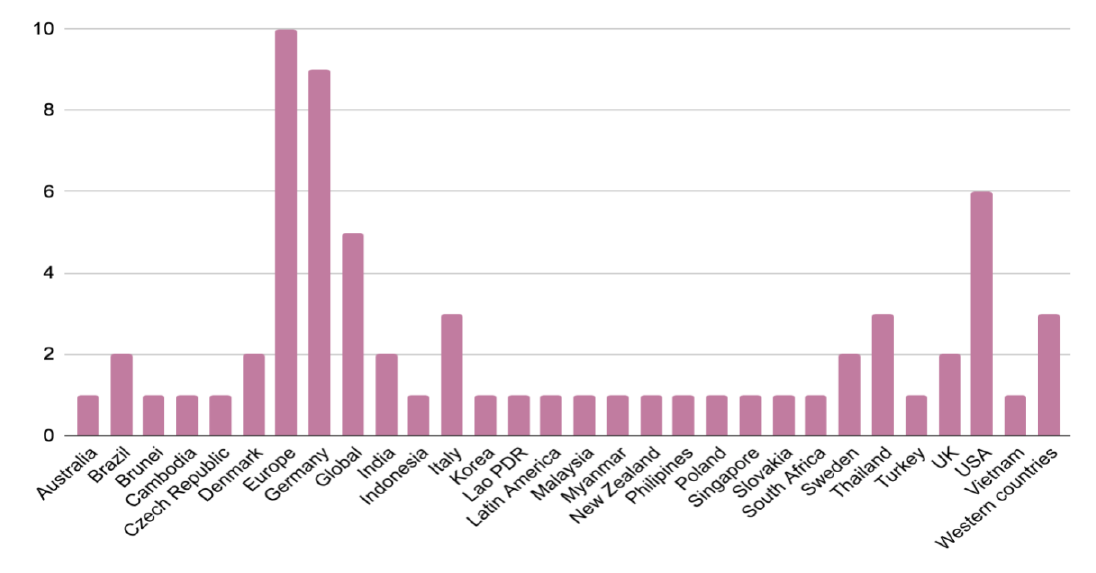
Figure 1. Geographical